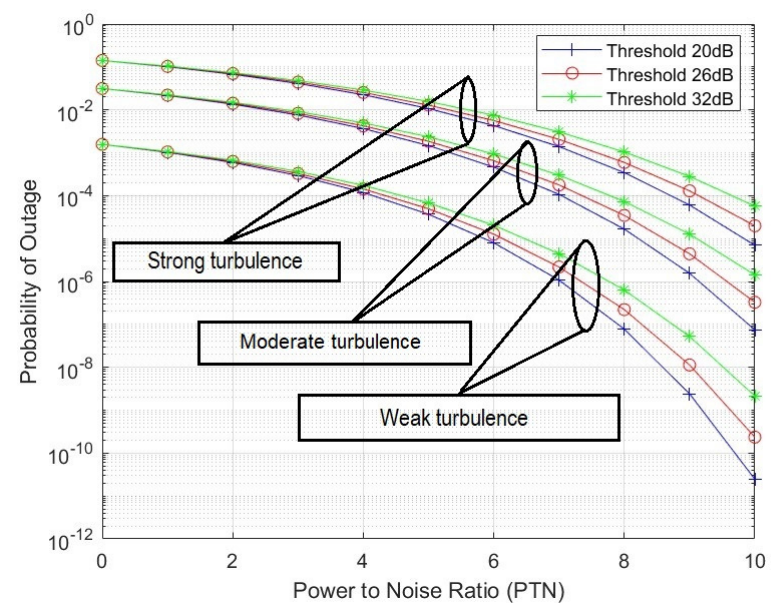
Figure 3. Probability of outage for the fixed PTN.